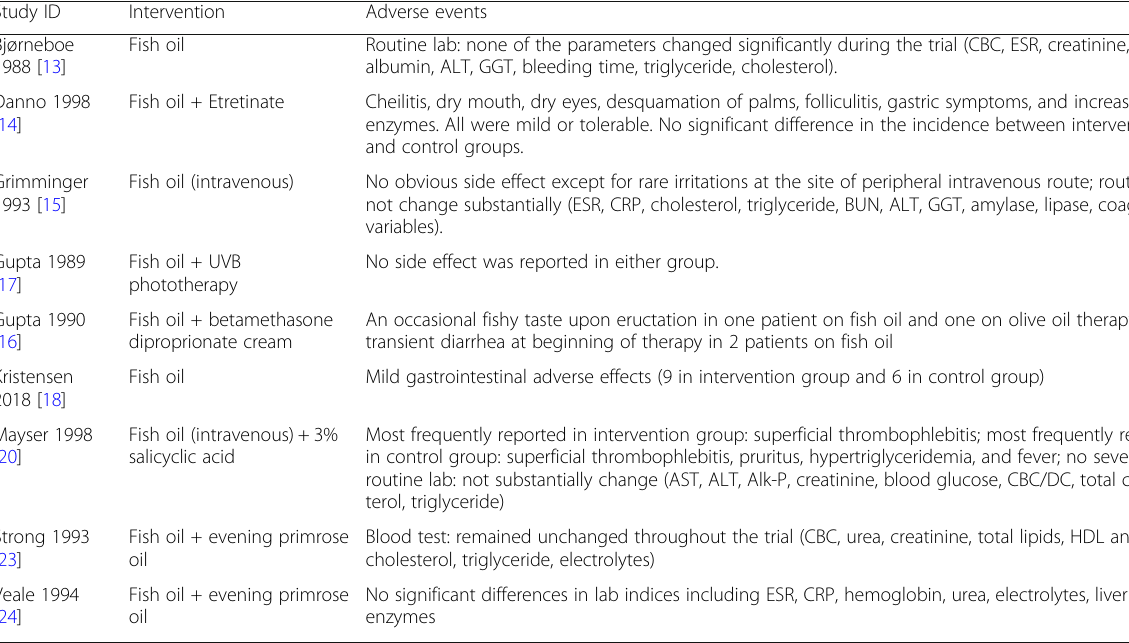
Table 3 Adverse events